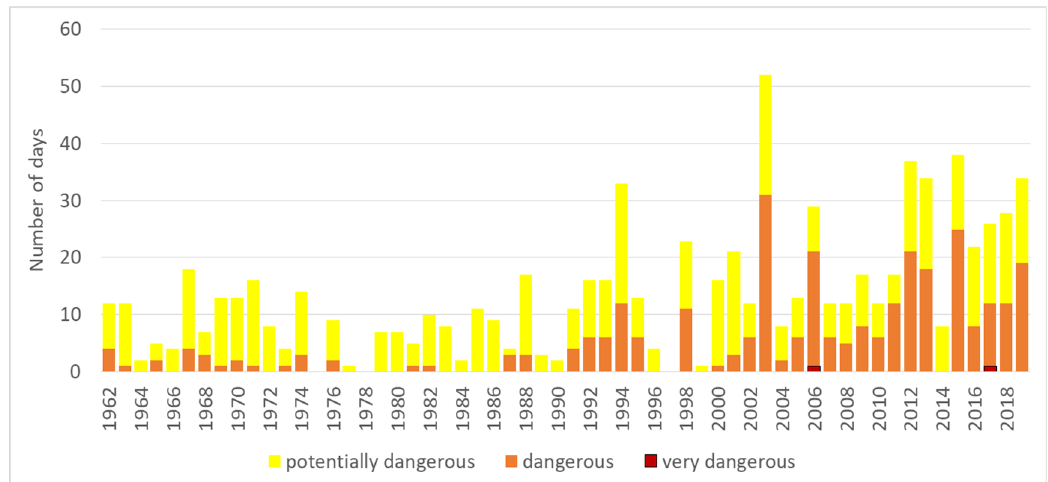
Figure 4. The number of days with fulfilled criteria for the potentially dangerous (yellow), dangerous (orange) and very dangerous (red) levels of meteoalarm in Bilje in the period 1962‒2019.